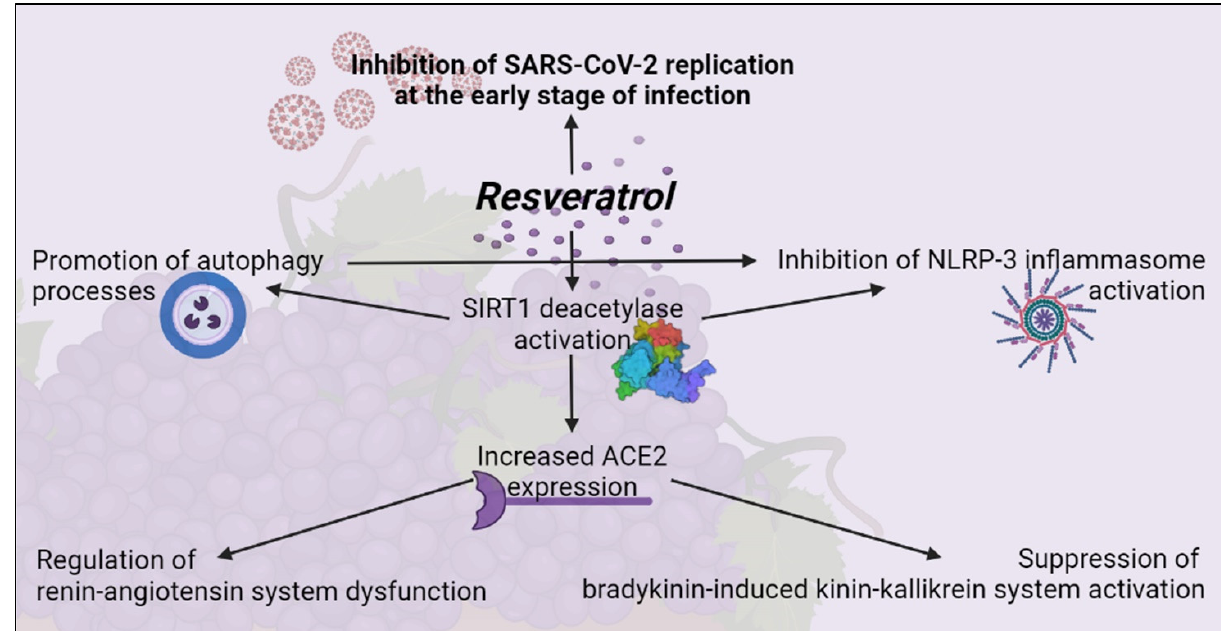
Figure 3. RSV inhibits SARS-CoV-2 replication at an early stage of infection. Created with BioRen- der.com (Web online version 2021. Accessed on 28 December 2021).